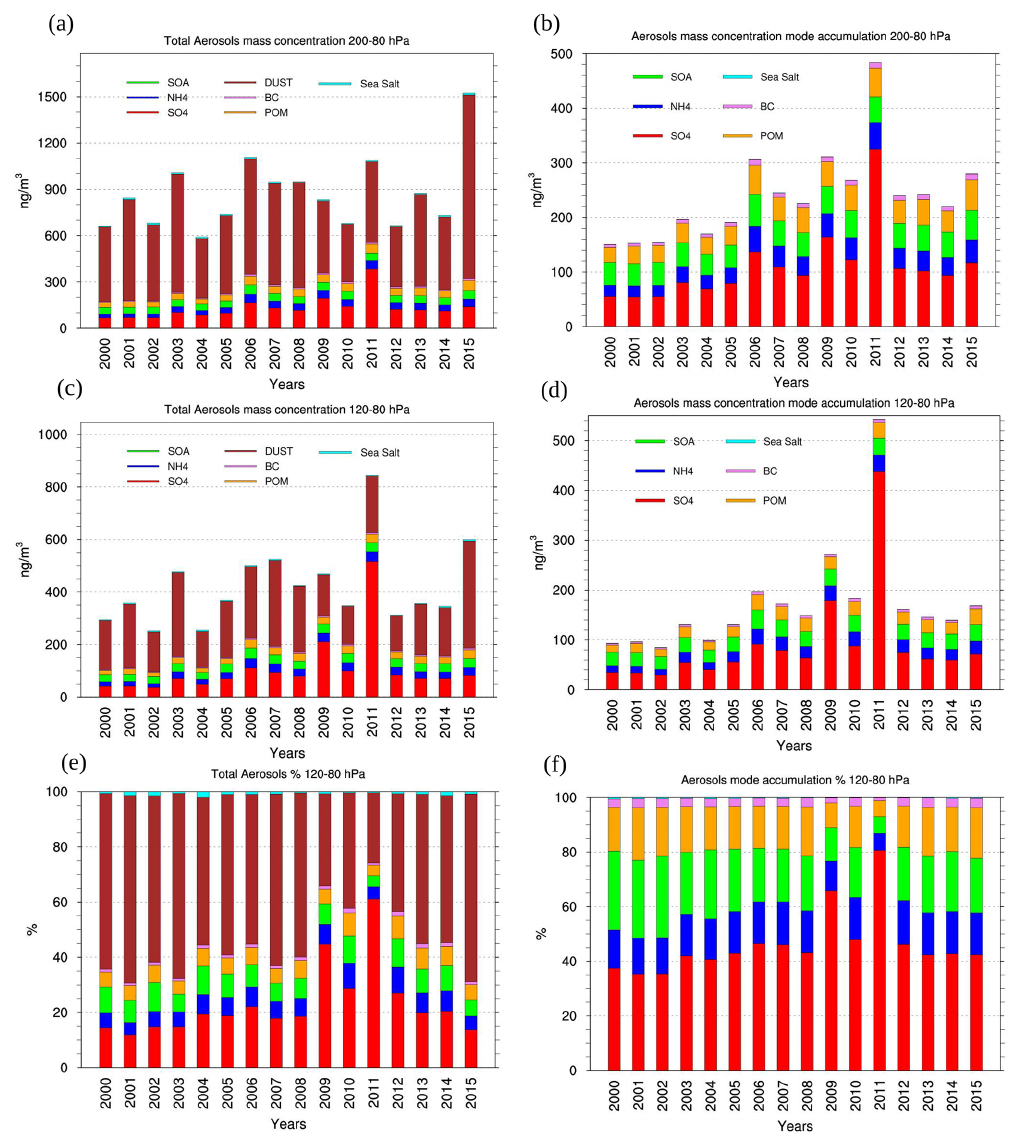
Figure 4. Evolution of the total aerosol mass concentration of all the aerosol types present in CESM-MAM7 in all the modes averaged at 20–35 ◦ N, 60–100 ◦ E for July–August, (a) between 200 and 80hPa, (c) between 120 and 80hPa, and (e) percent amount at 120–80hPa. (b) , (d) and (f) are the same as (a) , (c) and (e) but only for the aerosols in the accumulation